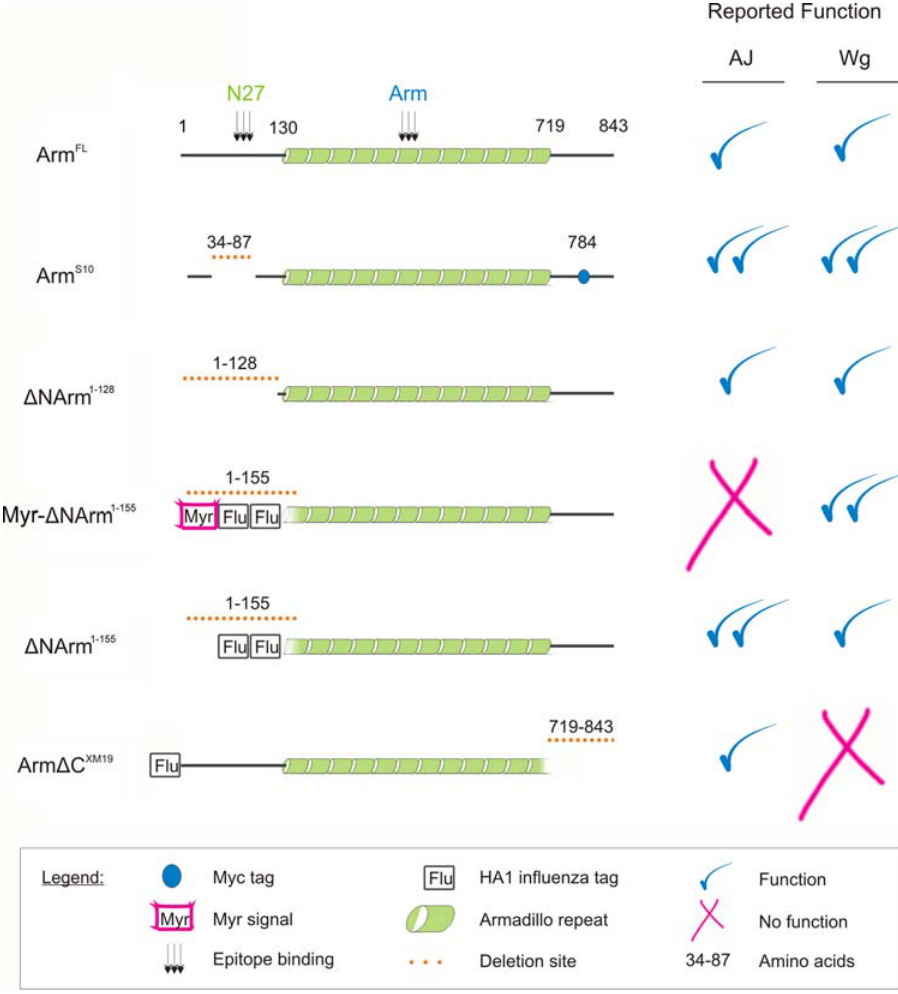
Figure 1. Armadillo UAS constructs used and their proposed function in AJs and Wingless signalling. Arm FL is a full length protein containing N-terminal, Armadillo repeat and C-terminal domains of the wild type protein, and functions in both adherens junctions (AJ) and in Wingless (Wg) signalling. The epitope binding sites of the two antibodies used in this study are shown in the N-terminal (N27) and Armadillo (Arm) repeats. The Arm S10 mutant contains the same Myc tag as well as a deletion of amino acids 37–84 in the N-terminus, including the Sgg/GSK3 b phosphorylation site, and is a constitutive form activating Wg targets. It is also very stable in the AJ. Three Armadillo constructs lack almost the entire N-terminus and include D NArm 1–128 (amino acids 1–128 deleted), Myr- D NArm 1–155 and D NArm 1–155 (both lacking amino acids 1–155). While D NArm 1– 128 is untagged and recapitulates wild type AJ and Wg function, Myr- D NArm 1–155 and D NArm 1–155 both possess tags derived from the influenza virus haemagglutinin protein HA1 (Flu) within the deleted portion of the N-terminus,and act as highly activated forms. Myr- D NArm 1–155 also contains a myristylation (Myr) signal sequence to target it to membranes. Finally, the Arm D C XM19 form lacks the entire C-terminus, and is Flu tagged to allow detection. It is unable to rescue Wg function but like the other constructs has some function in the AJ. Please see text for